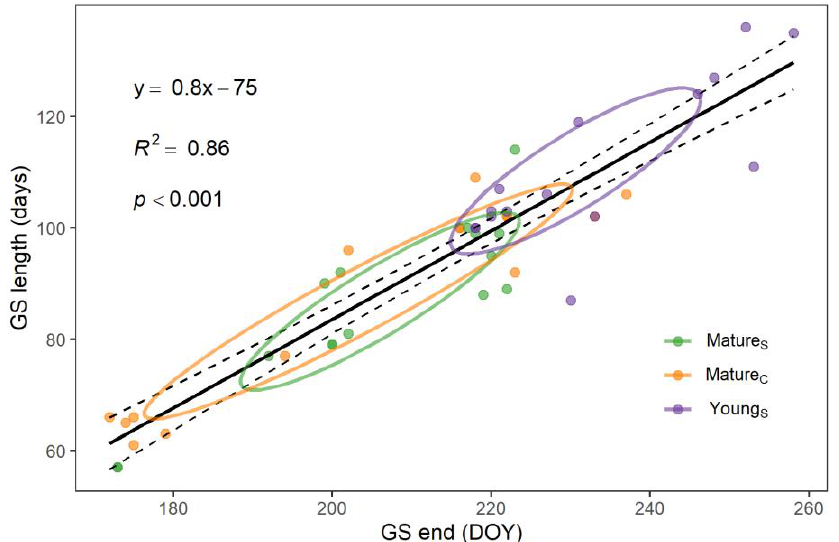
Figure 3. Linear relationship between length of growing season (GS) and day of year (DOY) when GS ended. Ellipses depict the t-distribution (confidence level 0.5) of data points from the geometric centre of each tree group and point to a longer GS which finished later in the YOUNG S tree group, while all tree groups showed a similar relationship (see also Figure S3).